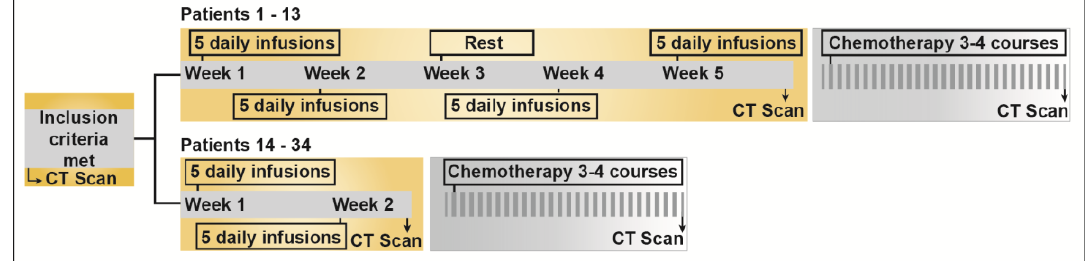
Table 1. Dose Exposure/Escalation Design.